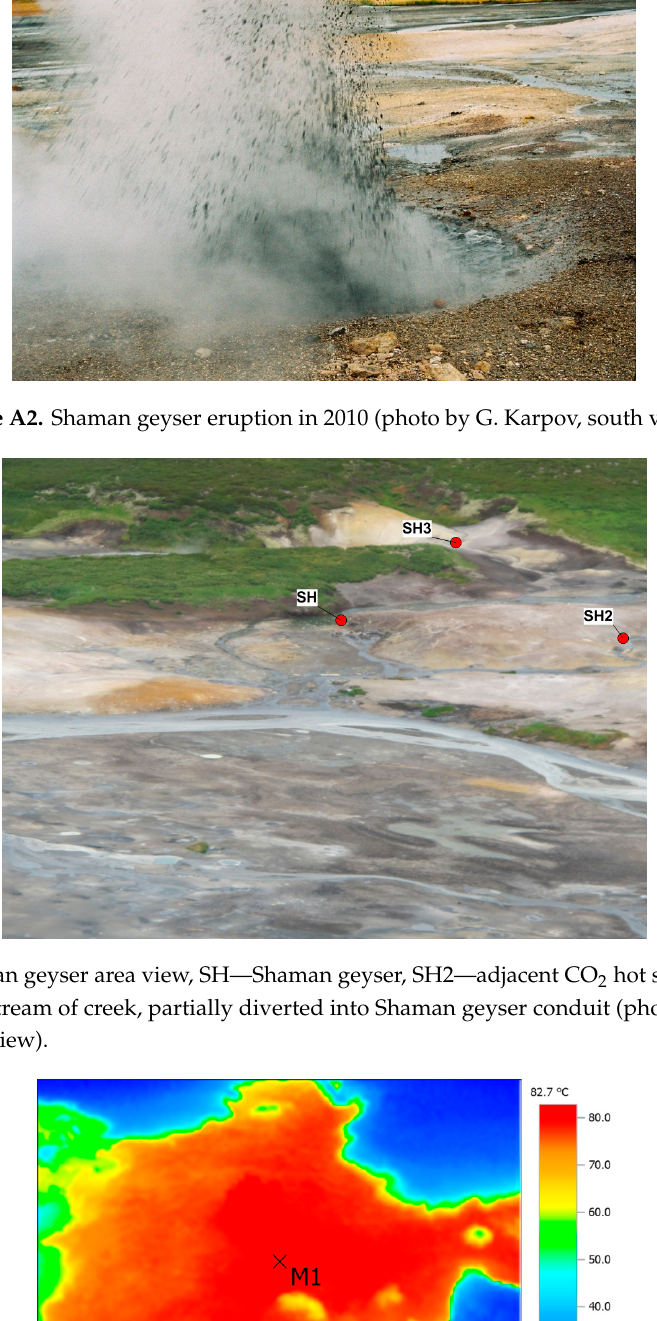
Figure A1. Shaman conduit view in 2010 (photo by G. Karpov, south view).